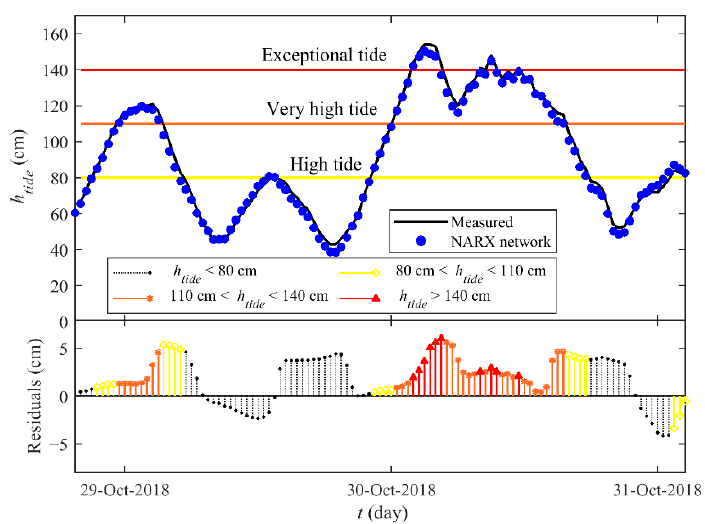
Figure 10. Exceptional high tide in Punta della Salute (event of 28–31 October 2018): comparison between measured time series and predicted values with Model IV and t a = 72 h ( upper chart ), Residuals ( lower chart